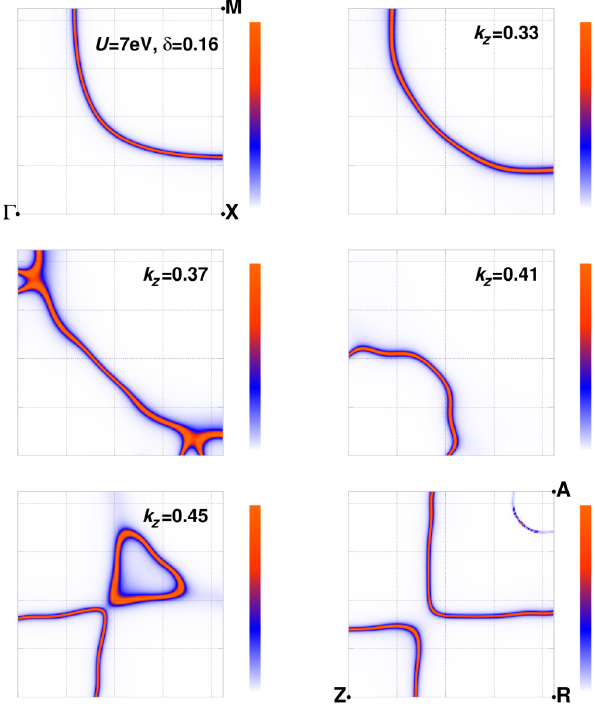
FIG. 11. Interacting Fermi surface along k U ¼ 7 eV and μ